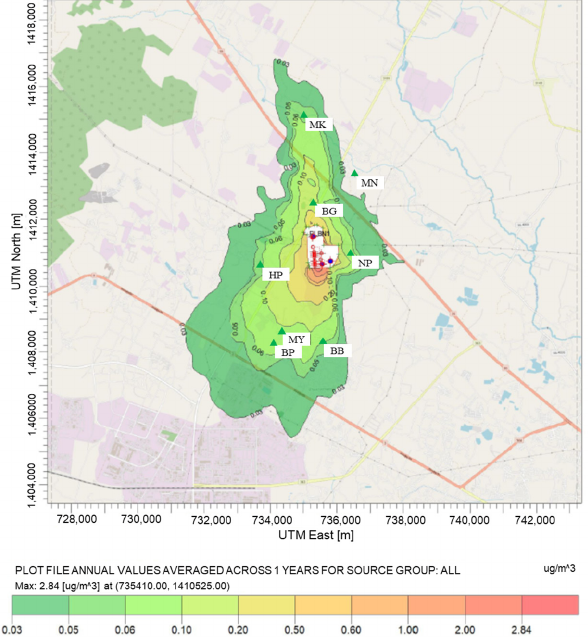
Figure 6. Spatial distribution of average annual toluene concentration.